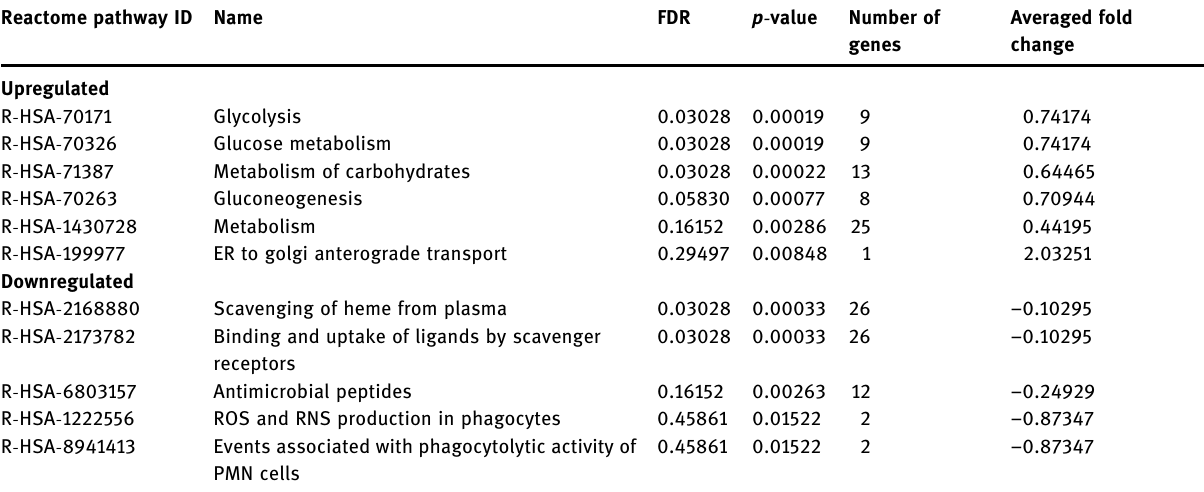
Table 7: Pathway enrichment analysis of top fi ve signi fi cantly up - and downregulated Reactome signaling pathways according to their p - value between TMD patients and the healthy control group Reactome pathway ID